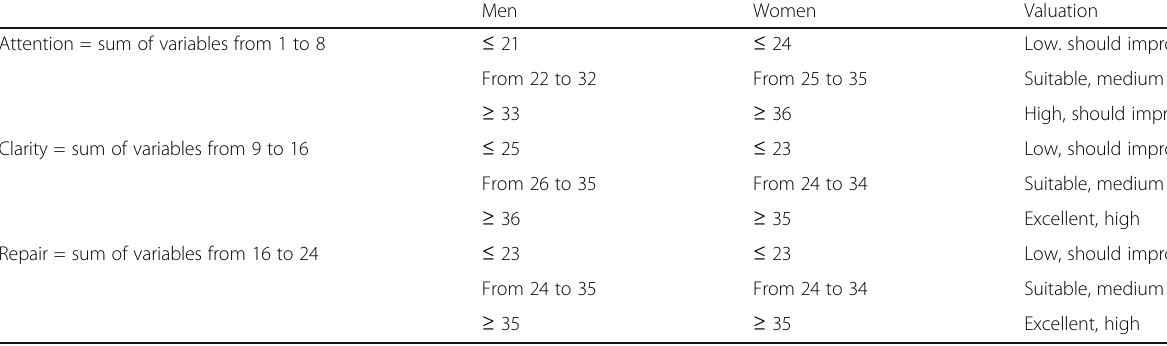
Table 1 Interpretation of the scores of TMMS-24 of Fernandez-Berrocal et al., 2004